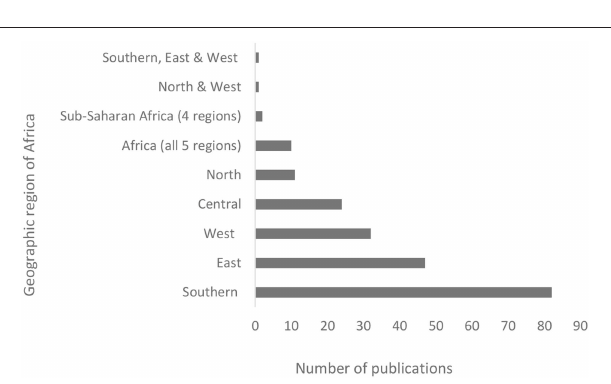
( n = 114) published in the past 6 years (2010–2016; Figure 1